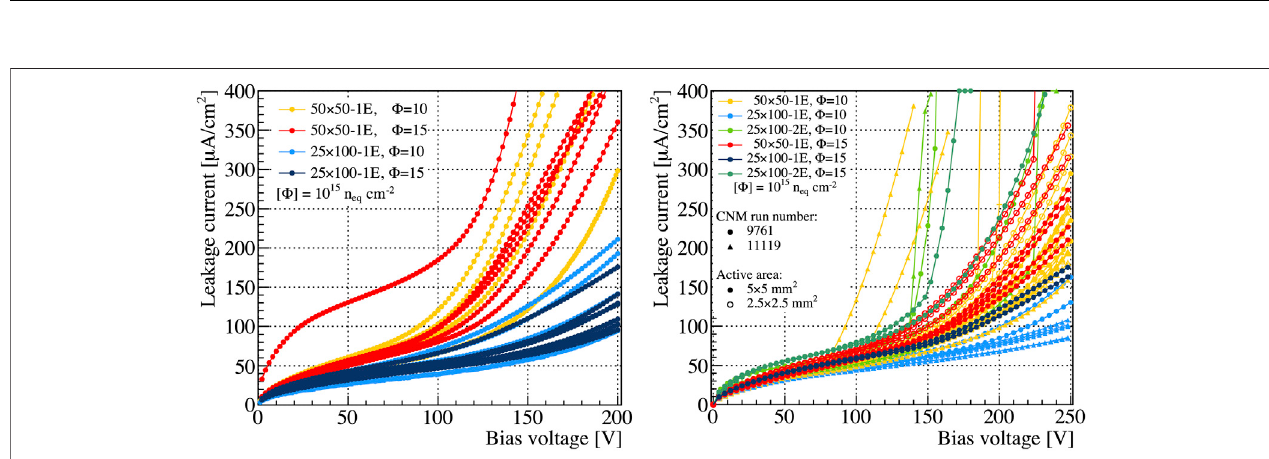
FIGURE 8 | I-V curves of 3D diodes with different pixel geometries after neutron irradiation at JSI, Ljubljana. On the left diodes from the FBK second and third batches. On the right diodes from the CNM runs 9761 and 11119.